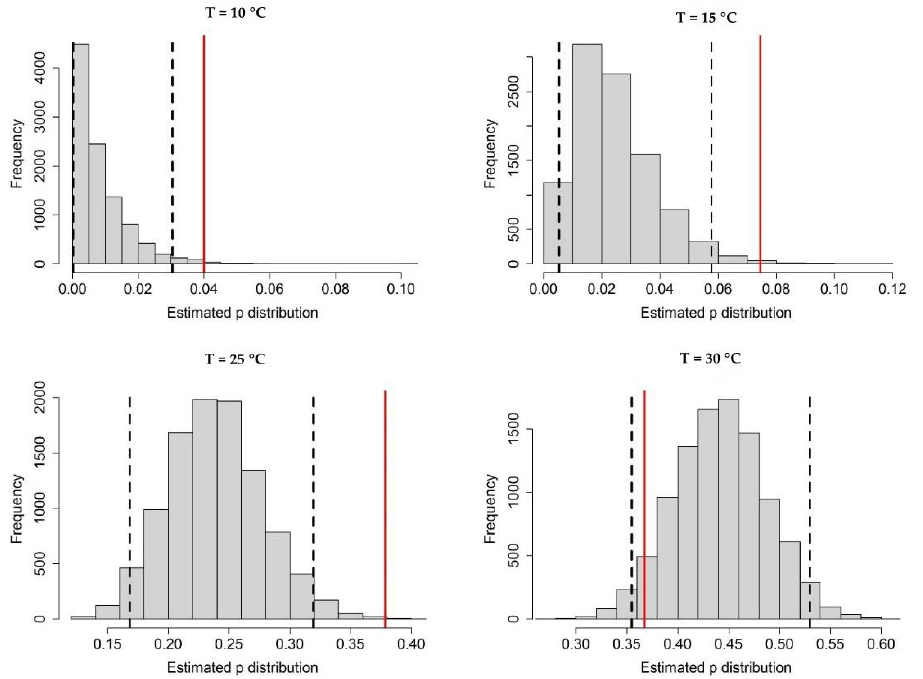
Figure A2. Estimated posterior distributions of P E (T), the egg hatching rate at 10, 15, 25, and 30 °C. Dashed black lines represent the 2.5 and 97.5 quantiles. Solid red lines represent the average value for subtropical Ae. albopictus .